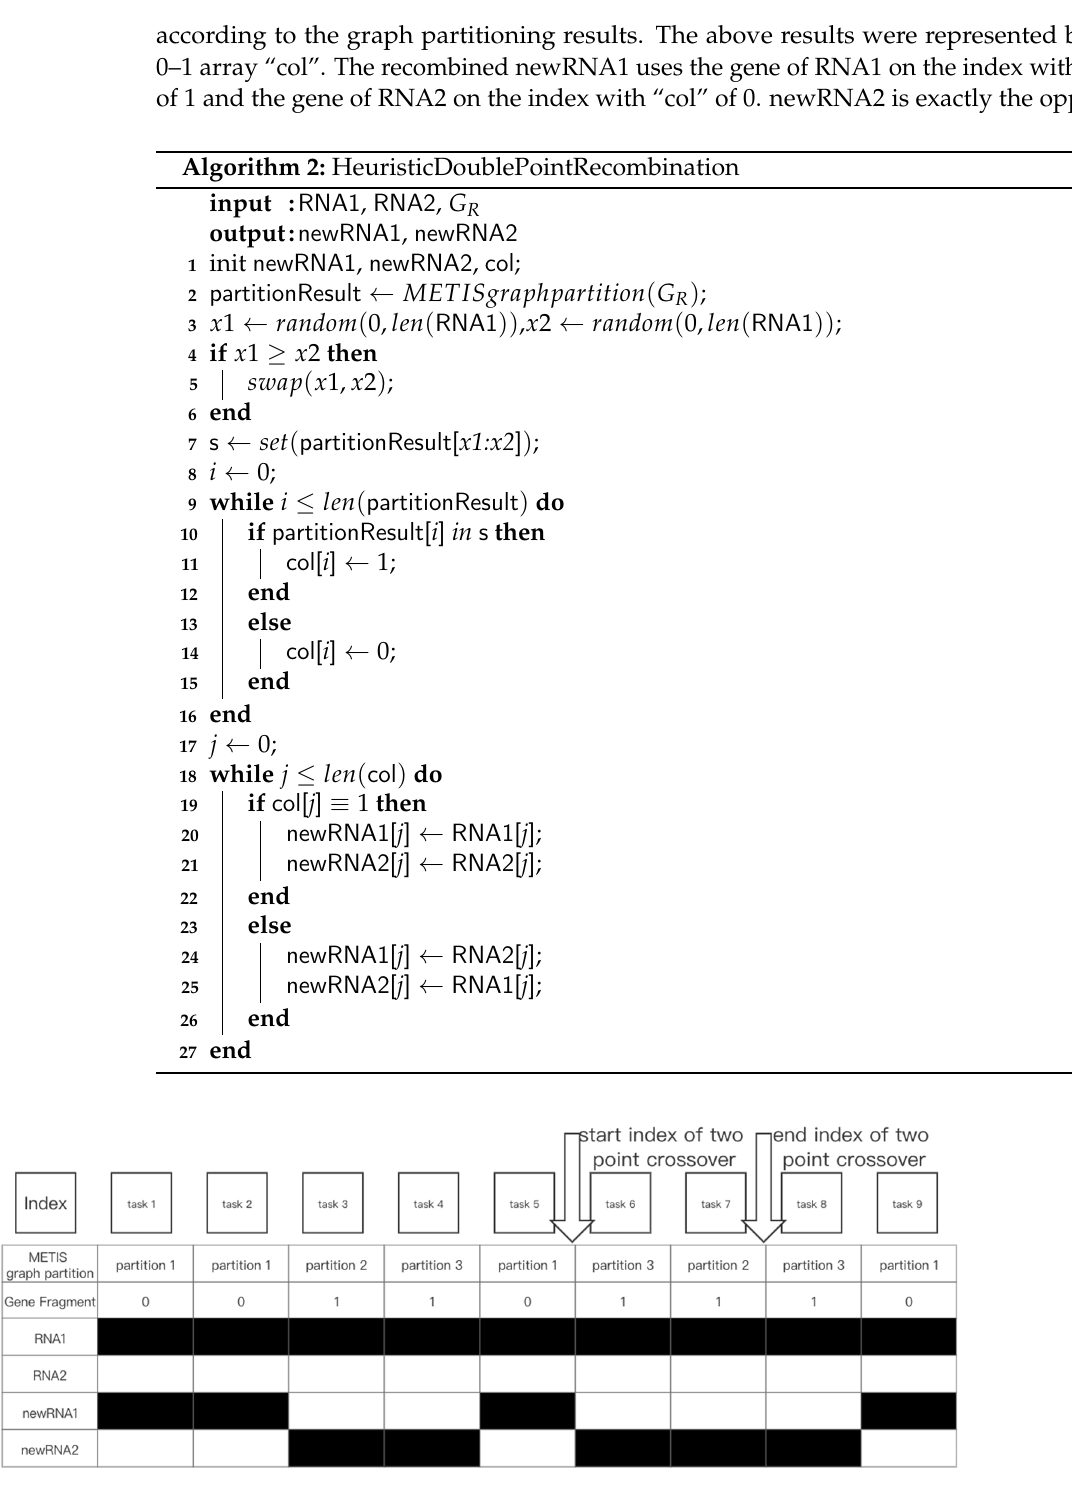
Figure 6. Process of Heuristic Recombination.